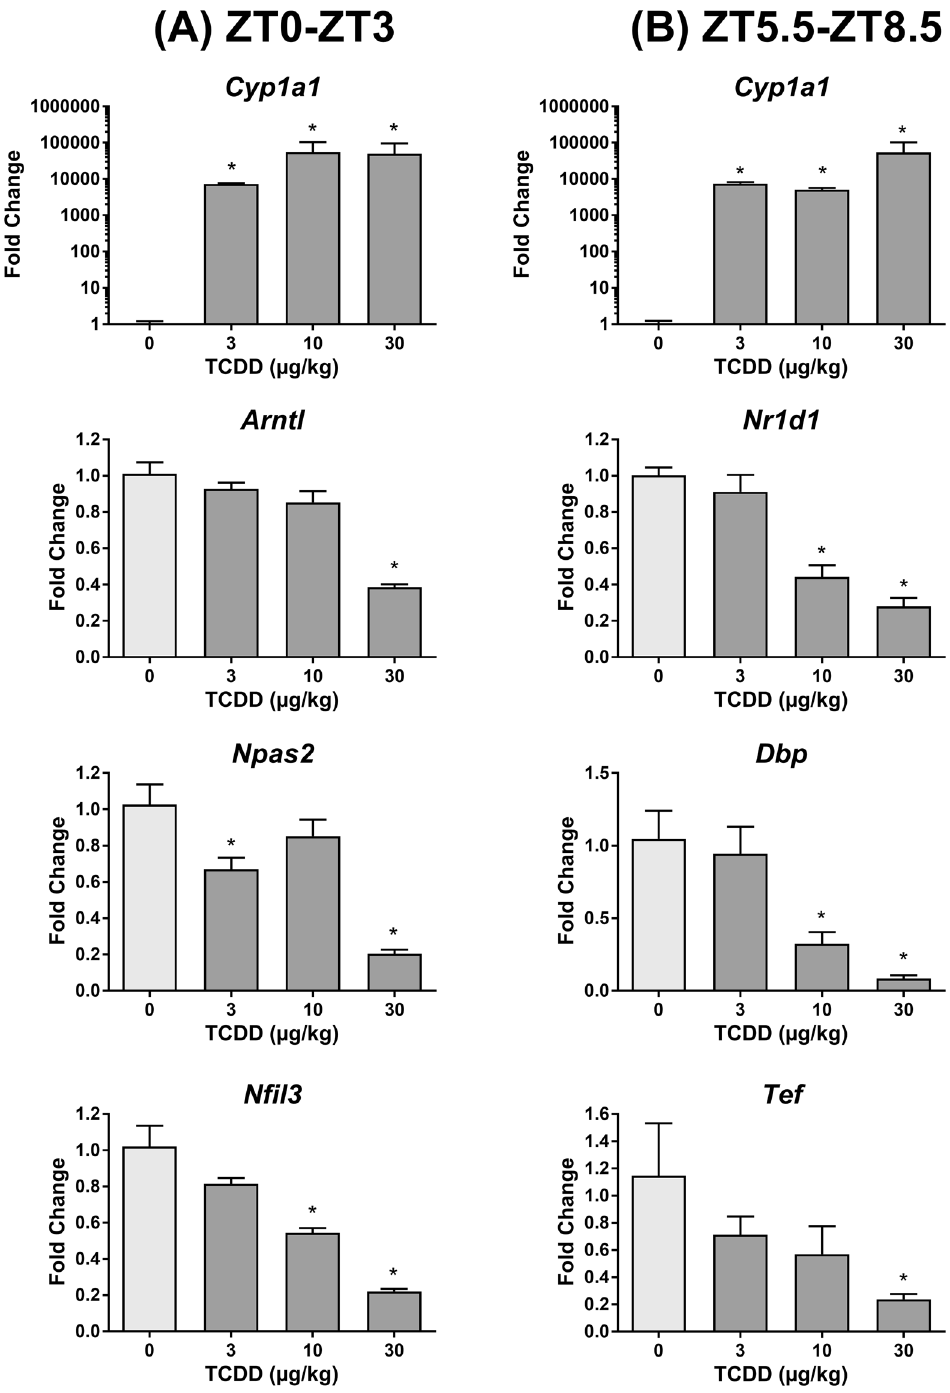
Figure 4. Dose-dependent effects of TCDD on the hepatic expression of core clock genes determined by quantitative real-time polymerase chain reaction (qRT-PCR). Male C57BL/6 mice were orally gavaged with sesame oil vehicle or 3–30 µ g/kg TCDD every 4 days for 28 days. On day 28, livers were collected at either ( A ) ZT0–3 or ( B ) ZT5.5–8.5. Bars represent the average of at least 3 individual mice + standard error of the mean. Target genes were normalized to Gapdh and Actb expression. Statistical significance compared to vehicle controls ( * p ≤ 0.05) was determined using a one-way ANOVA analysis followed by Dunnett’s post-hoc